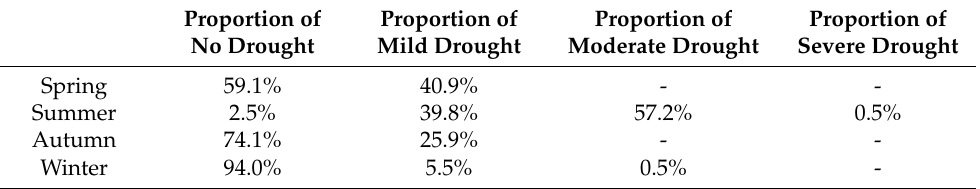
Figure 3. Spatial distribution of seasonal SPEI average ( a1 – a4 ) and drought magnitudes ( b1 – b4 ) in the Loess Plateau from 2001 to 2019. Table 2. Percentage of the area under different drought magnitudes in each